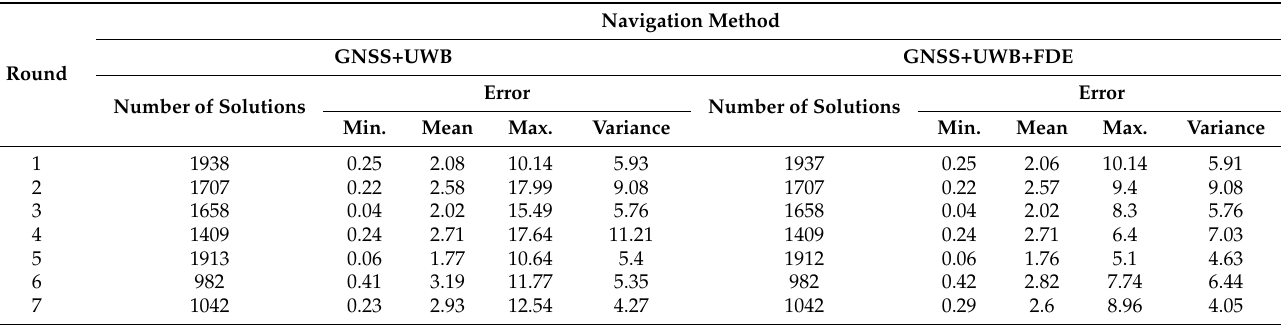
Table 3. Obtained results over multiple